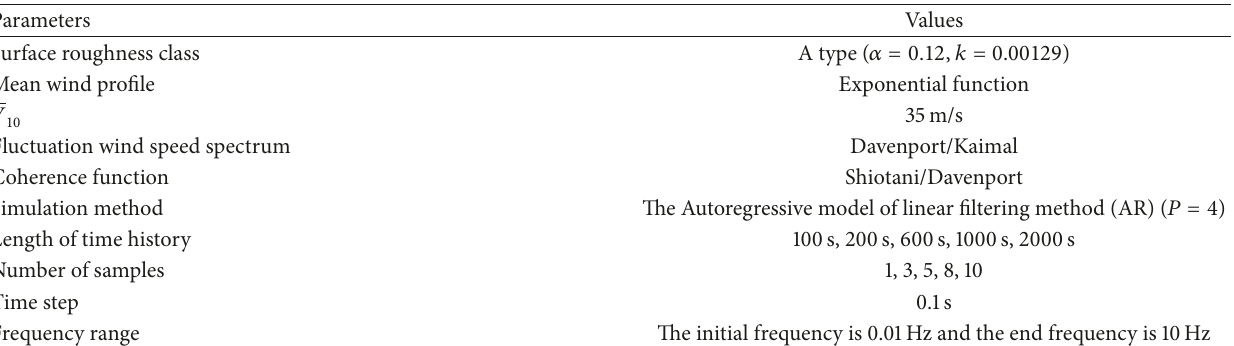
Table 2: The main parameters of wind speed simulation.